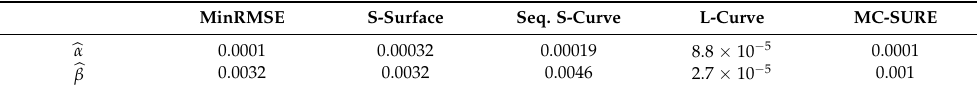
Table 1. The spatial ( (cid:98) α ) and temporal ( (cid:98) β ) regularization parameters for the simulated test case with 5% noise level obtained with the S-surface, Sequential S-curve, L-curve and Monte-Carlo SURE (MC-SURE) methods and the MinRMSE parameters used as reference. The table shows that the parameters obtained with the proposed methods (S-surface and Sequential S-curve) and MC-SURE are close to the optimal (MinRMSE) whereas the parameters obtained with the L-curve-method are further from the optimal.